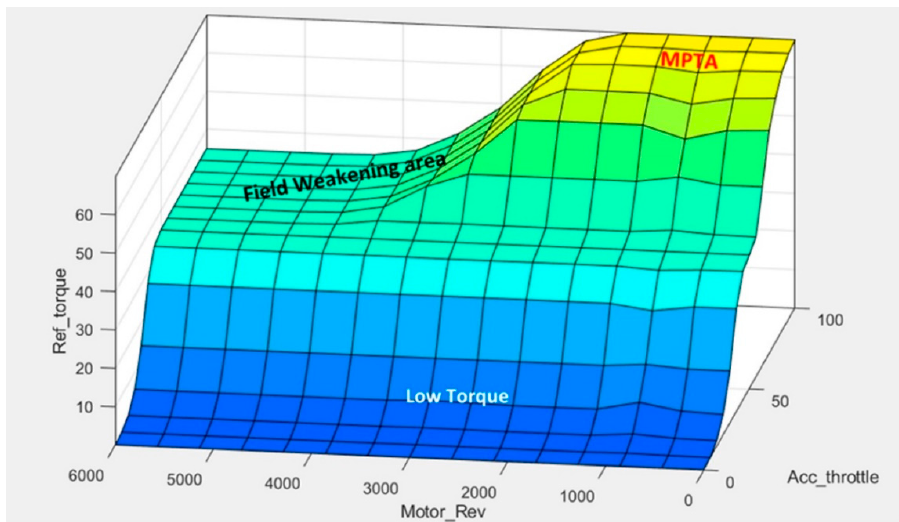
Figure 9. Three-dimensional lookup table for the IPMSM range of operation. Figure 9 consists of three axes, including the Acc_Throttle, Motor_Ref, and Ref_Torque.